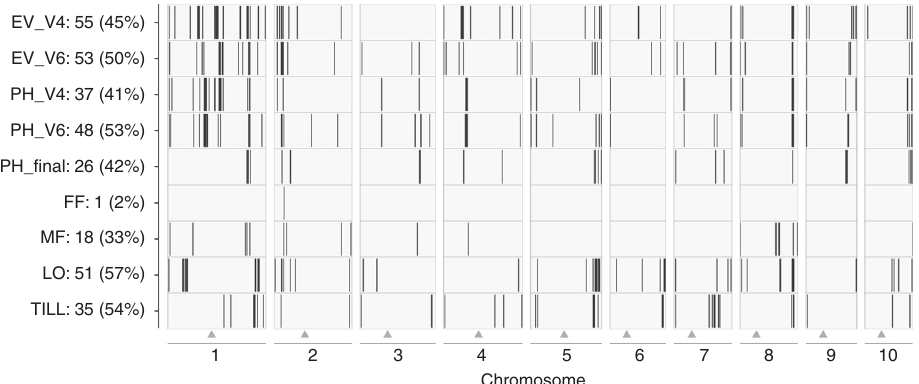
Fig. 2 Results from GWAS in DH libraries derived from maize landraces. Black vertical bars indicate the position of genomic regions signi fi cantly associated with nine traits ( y -axis) in 899 landrace-derived DH lines. The x -axis shows the ten chromosomes of maize. Triangles mark the position of the centromere for each chromosome. The y -axis indicates the trait, the number of signi fi cant regions per trait, and the percentage genetic variance